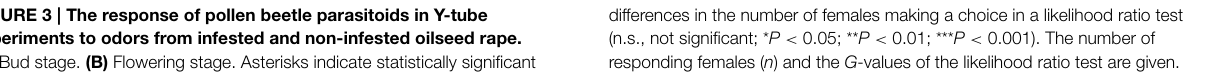
differences in the number of females making a choice in a likelihood ratio test (n.s., not significant; * P < 0.05; ** P < 0.01; *** P < 0.001). The number of responding females ( n ) and the G -values of the likelihood ratio test are